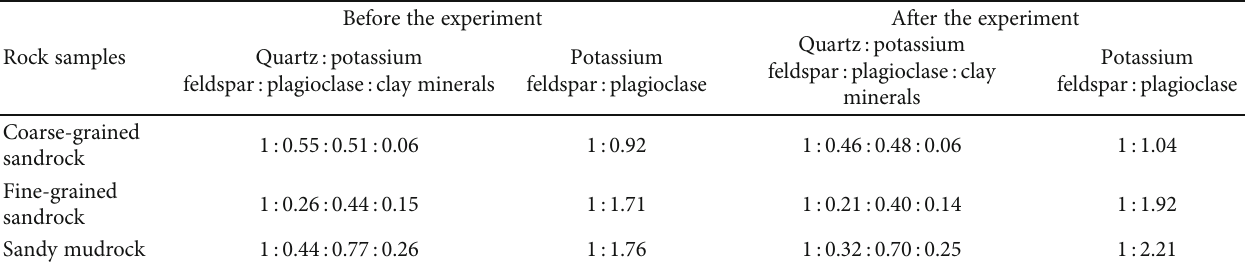
Table 3: Fracture-surface mineral compositions of the three rock specimens before and after the experiment. Before the experiment After the Rock samples